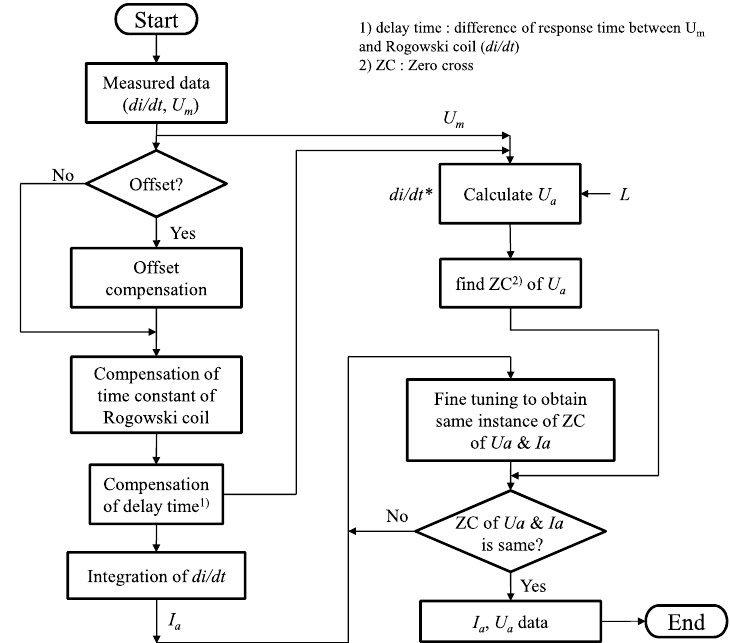
Figure 3. Procedure of current and voltage signal processing at current